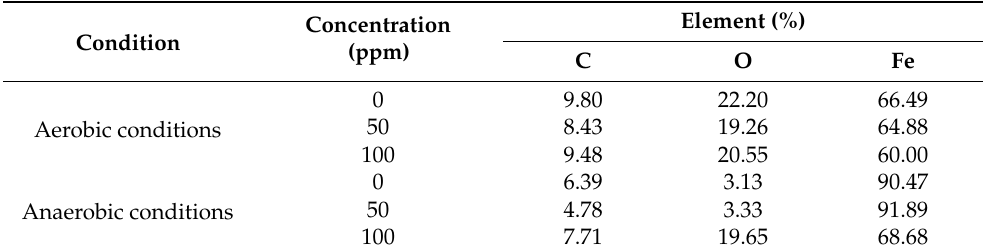
Table 1. Energy dispersive X-ray (EDXA) results (wt.%) of corrosion products on the surface of samples.